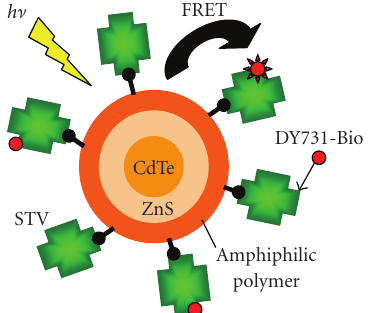
Figure 1: Schematic diagram of Qdot705-STV and DY731-Bio in self-assembled assay where energy can be transferred nonradiatively from QD to DY731-Bio upon